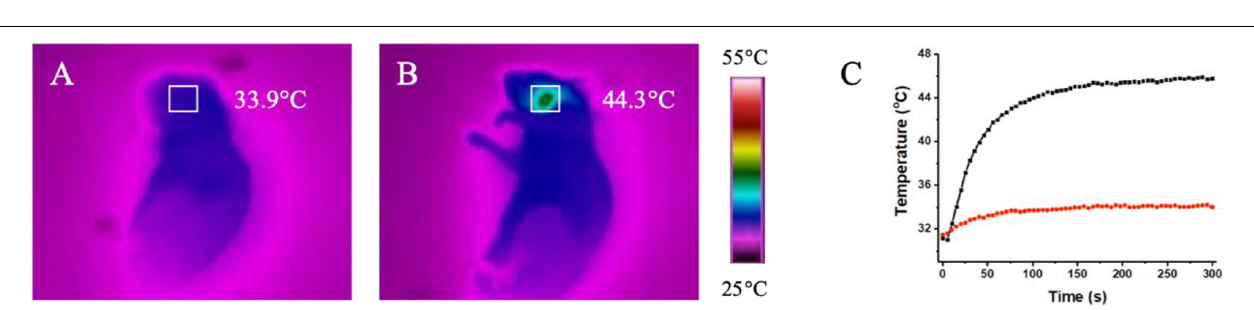
FIGURE 7 | In vivo thermal effect of CuBiS 2 NPs in vivo . (A,B) Representative of infrared thermal images of the mice after being injected with PBS or CuBiS 2 NPs under laser irradiation. (C) Temperature changes according to irradiation time in corresponding squared regions (red: PBS control; black: CuBiS 2 NPs group).